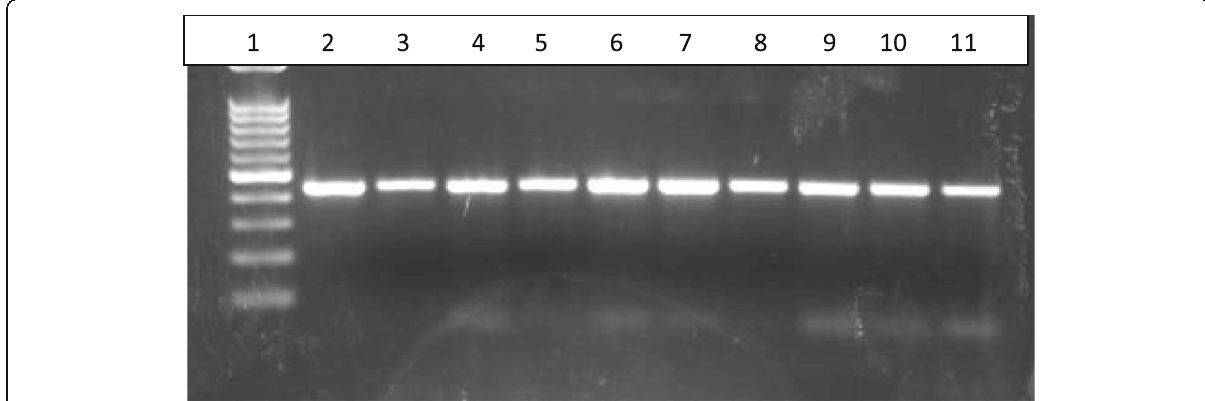
Fig. 1 PCR product on agarose gel before digestion appearing as bands at 433 base pair on electrophoresis (lanes 2-11). Molecular weight marker (100 bp) (lane